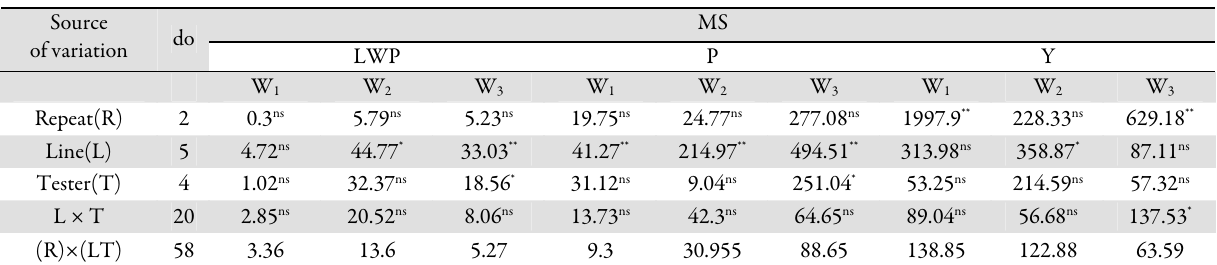
Tab. 2.2. Analysis of variance of line × tester in sunflower for leaf water potential (LWP), proline content (P) and yield (Y) at the